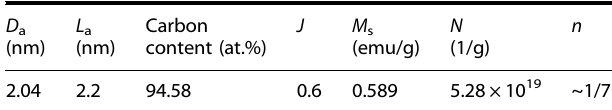
Table 1. Microstructure and magnetic properties of